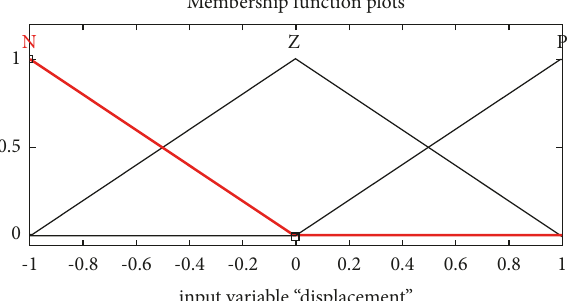
Table 7: Fuzzy rule database for